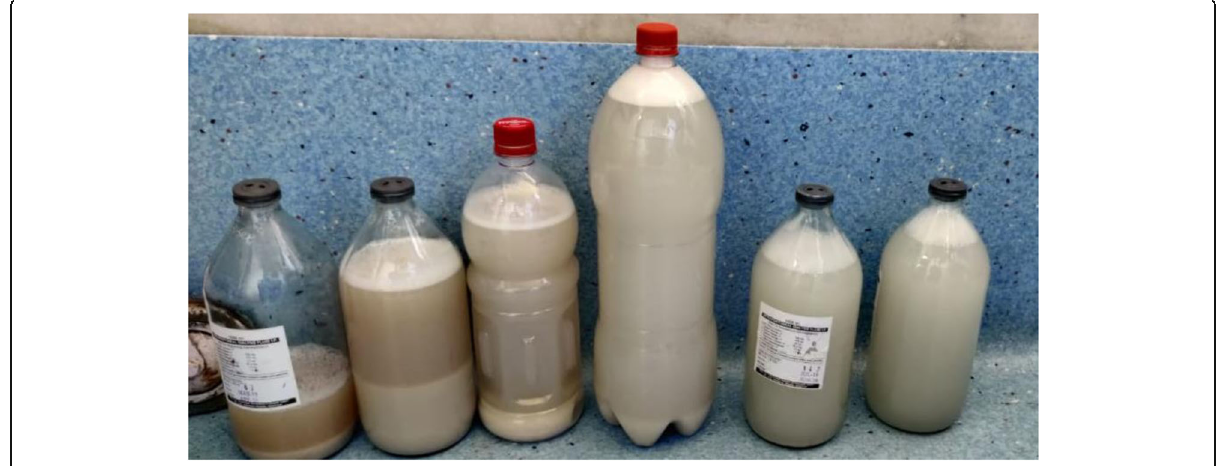
Fig. 3 Lavage fluid for visual